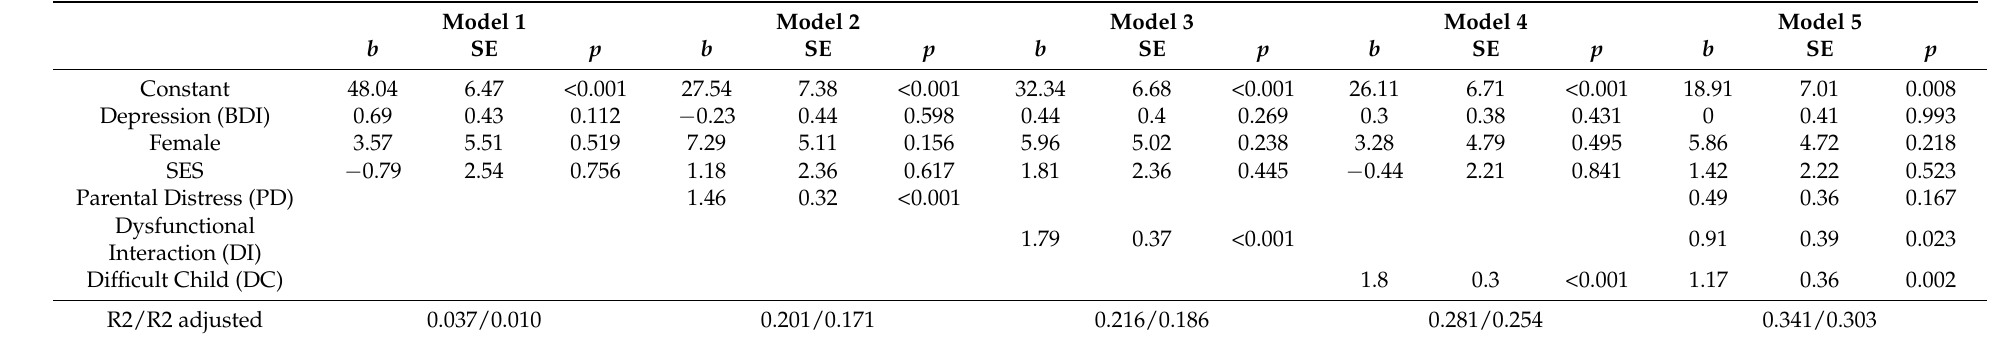
Table 4. b -Values and R-Squared of the five Linear Regression